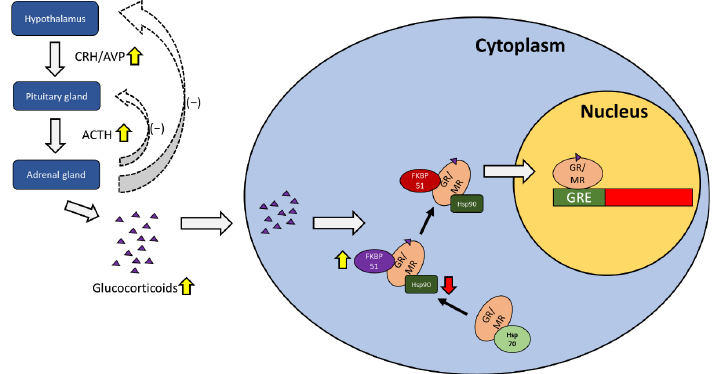
Figure 1 . The role of the GR/MR in the HPA axis under depression. The hypothalamus releases corticotropin-releasing hormone (CRH) and arginine-vasopressin (AVP), acting on the pituitary gland which in turn releases adrenocorticotropic hormone (ACTH) to stimulate the adrenal gland. The adrenal gland plays a role in the negative feedback loop for the hypothalamus and the pituitary gland, while releasing glucocorticoids such as cortisol. Glucocorticoids travel into the cell and bind to GRs or MRs, with the help of Hsp90 and FKBP51, before being transported into the nucleus with the aid of FKBP52 where they activate GREs for subsequent gene transcription. During depression, CRH and AVP are elevated, resulting in increased ACTH and increased glucocorticoid release such as cortisol. Chaperone proteins such as FKBP51 may be elevated while others such as Hsp90 may be impaired in function. 3. Gender Differences of Cortisol in Clinical Studies 3.1. Recent Findings in Gender Differences of Cortisol Recent clinical studies in the PubMed/MEDLINE and EMBASE/Ovid were refer- enced to examine potential gender differences in cortisol expression. The majority of the studies conducted on salivary samples (Table 1) in the past 10 years discovered no signif- icant correlation between cortisol levels and depression symptoms between gender [8,41 – 49]. However, studies conducted specifically on younger subjects found that cortisol re- activity was higher in male children, particularly during a state of depression [50 – 54]. Male children tended to have higher cortisol levels than female children in depression [52,53], and while high cortisol levels were a risk factor for both genders, moderate cortisol levels could also be a risk indicator for depression in male children, and accordingly low cortisol levels could be a protective factor only for that gender [54]. With regards to serum cortisol studies (Table 2), two studies reported no correlation between gender and depression in their analysis of serum cortisol samples [55,56], while another study found that there was a correlation between cortisol levels and gender, with males demonstrating significantly higher serum cortisol levels [57]. Furthermore, de- pressed men also exhibited heightened cortisol reactivity, while depressed women had a blunted cortisol response in comparison [58]. Another study on serum cortisol performed in Japan showed that men had higher cortisol levels than women in the control group but not in the depressed group, whereas depressed women exhibited higher cortisol levels than women in the control group [59].